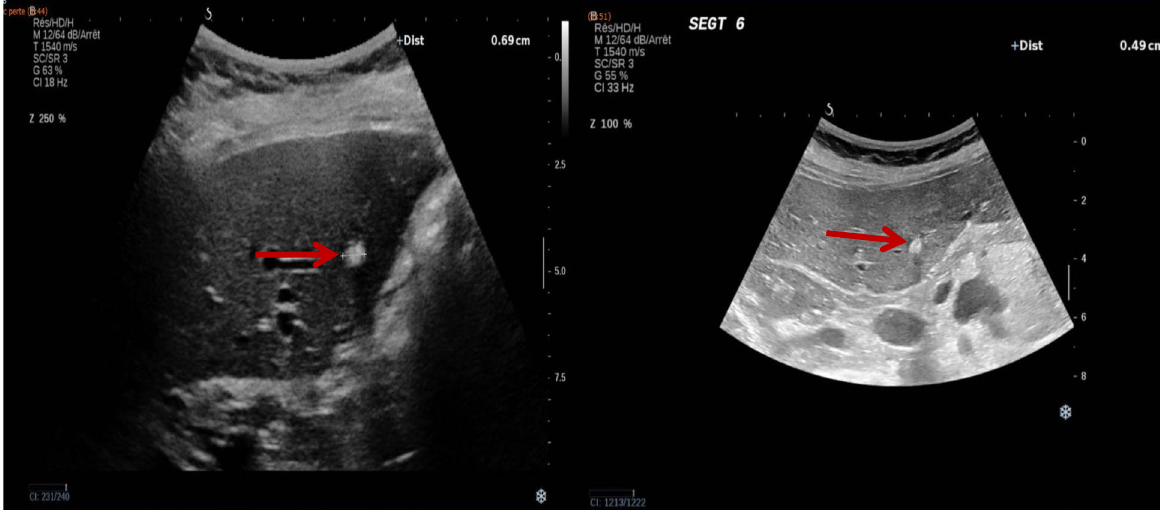
Fig. 2 Abdominal ultrasound showing the presence of comet tail artifacts along the intrahepatic bile ducts, consistent with LPAC